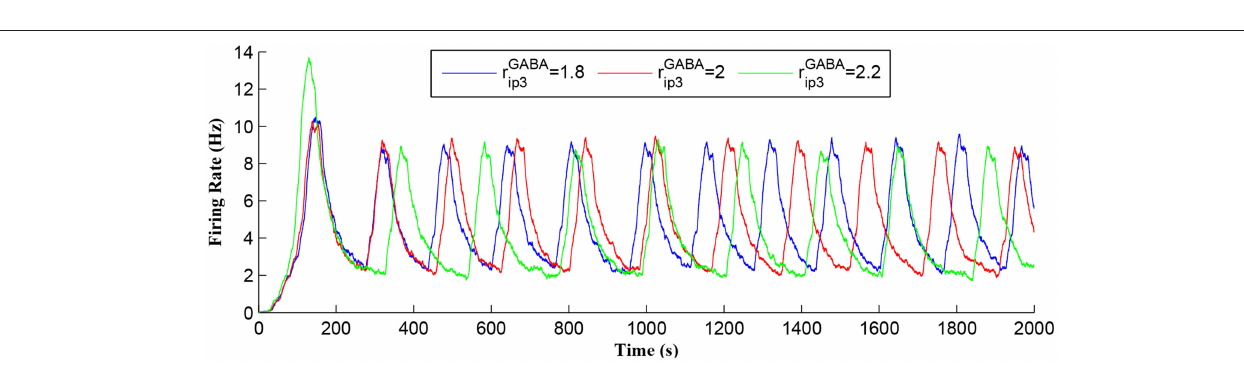
FIGURE 13 | Postsynaptic neuron burst firing as a function of time with IP GABA 3 production rates ( r GABA ip 3 ) as a parameter. When r GABA ip 3 increases, IP GABA 3